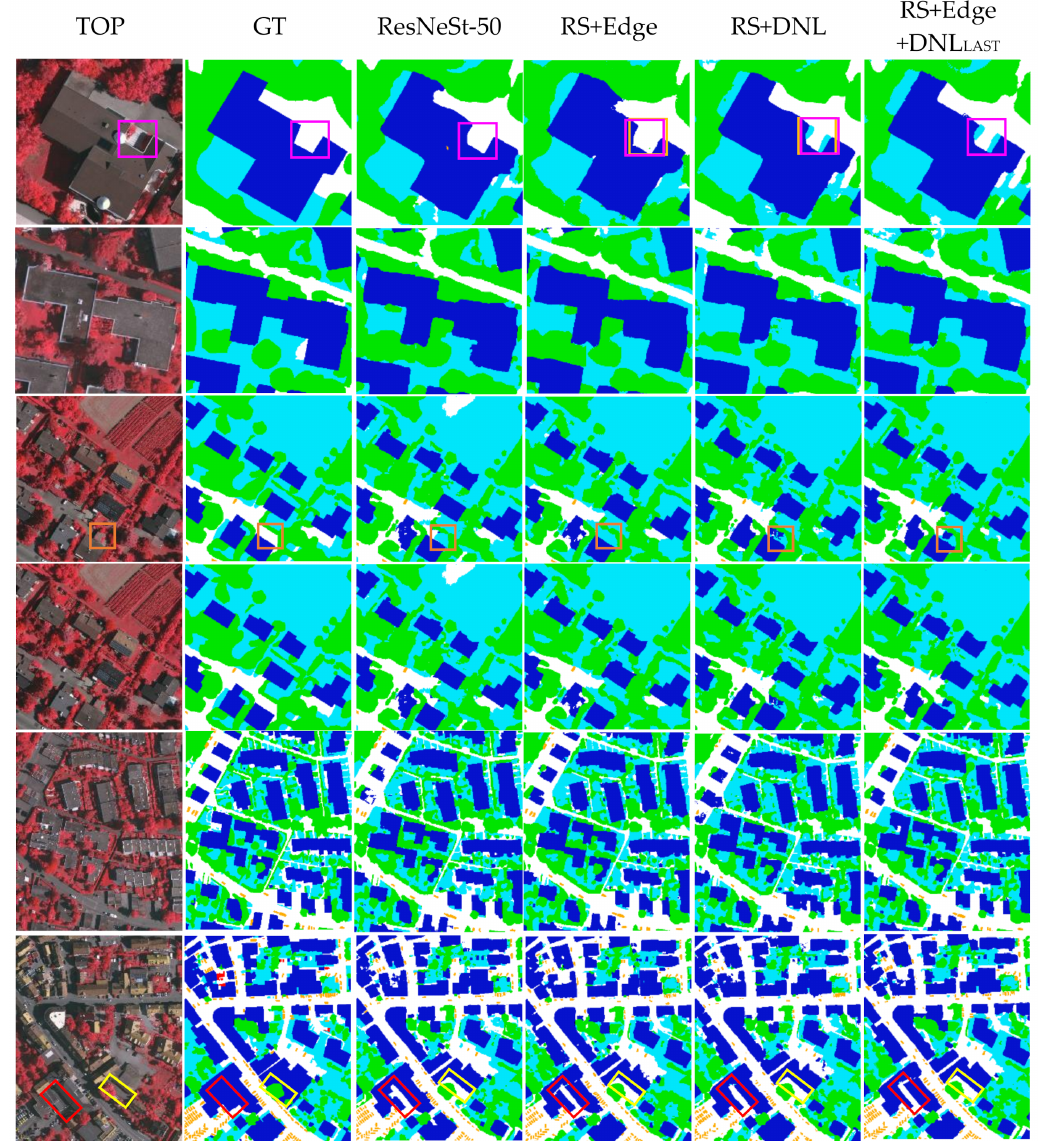
Figure 10. Examples of segmentation results on the Vaihingen dataset. The 3rd to 6th columns show the results of 50- layer ResNeSt, ResNeSt+Edge, ResNeSt+DNL, and ResNeSt+Edge+DNL methods. The boxes marked in figures are few inaccuracies in the ground